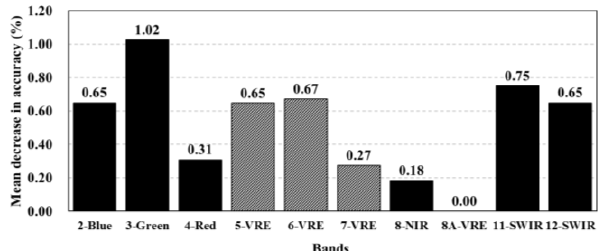
Figure. 5. Importance of the ten spectral bands (Bands 2, 3, 4, 5, 6, 7, 8, 8A, 11, and 12) of Sentinel-2 MSI